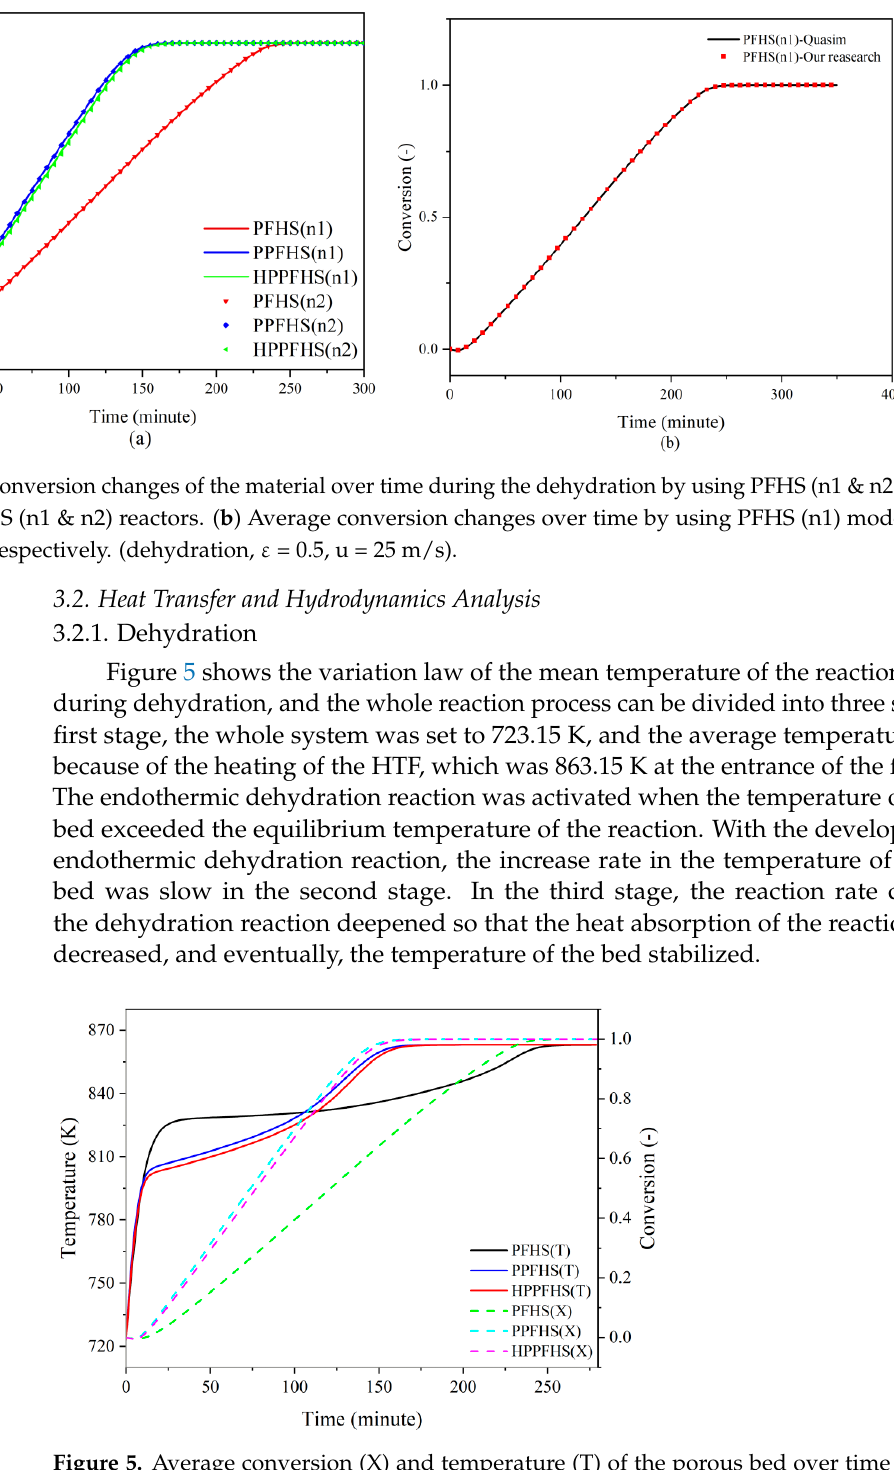
Figure 5. Average conversion (X) and temperature (T) of the porous bed over time for three heat transfer structures (dehydration, ε = 0.5, u = 25 m/s).